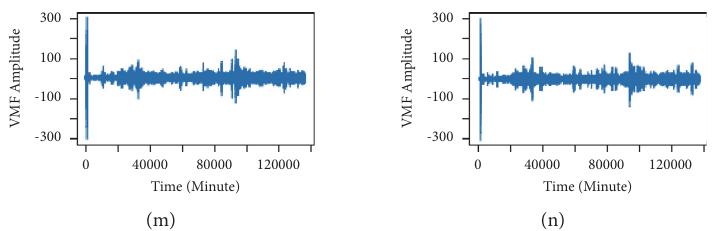
Figure 8: Variational mode decomposition of intraday Bitcoin price with 14 variational mode. (a) VMF #1. (b) VMF #2. (c) VMF #3. (d) VMF #4. (e) VMF #5. (f) VMF #6. (g) VMF #7. (h) VMF #8. (i) VMF #9. (j) VMF #10. (k) VMF #11. (l) VMF #12. (m) VMF #13. (n) VMF #14.